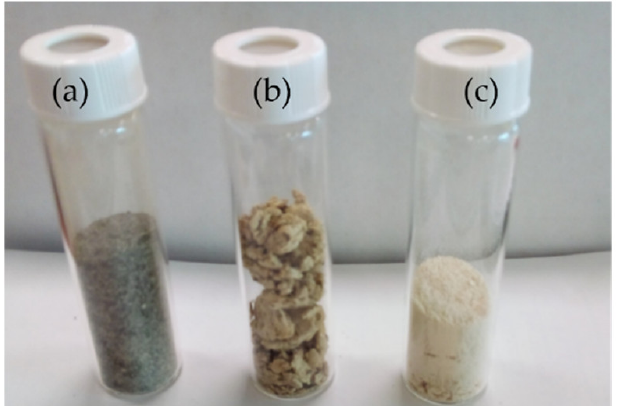
Figure 2. ( a ) L. digitata whole seaweed; ( b ) freeze-dried L. digitata hydrolysates generated using Viscozyme and the protease enzyme Alcalase ® and ( c ) the L. digitata permeate fraction generated by filtration with a 3-kDa MWCO filter permeate fraction recovered.